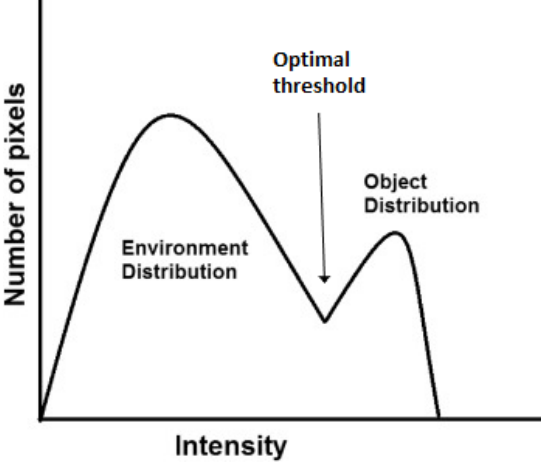
Figure 1. Optimal threshold in the bimodal